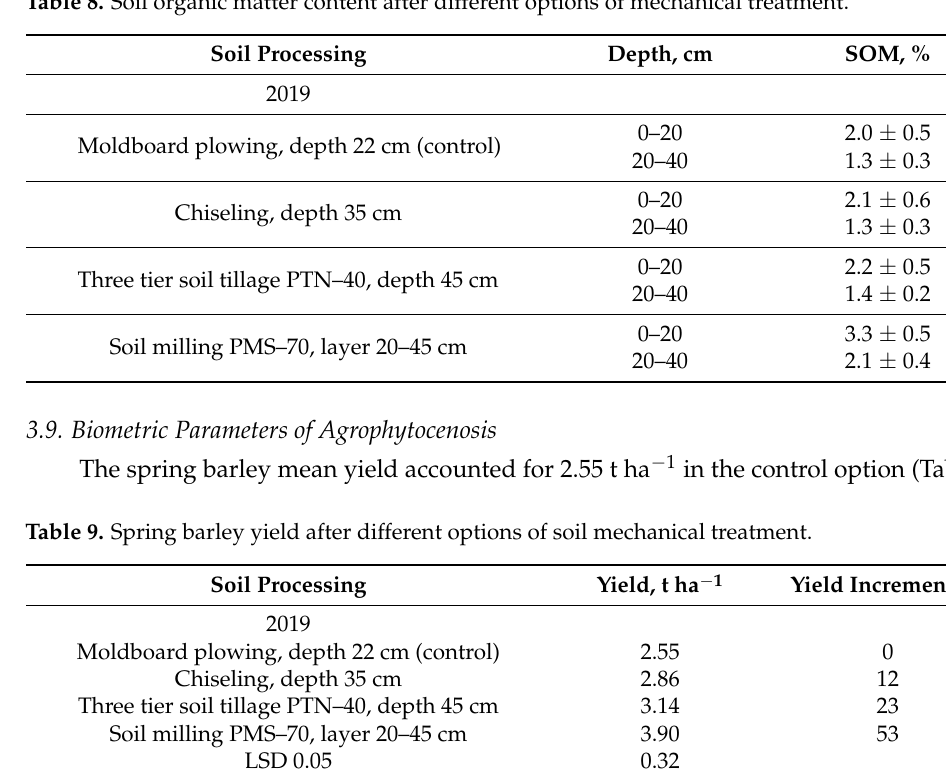
Table 8. Soil organic matter content after different options of mechanical treatment.